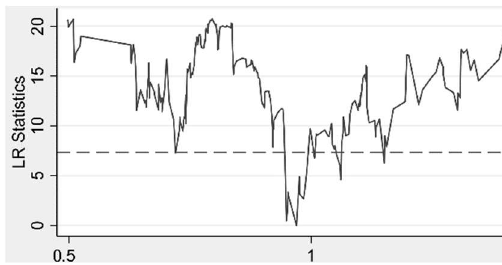
Figure 3. Second Threshold.